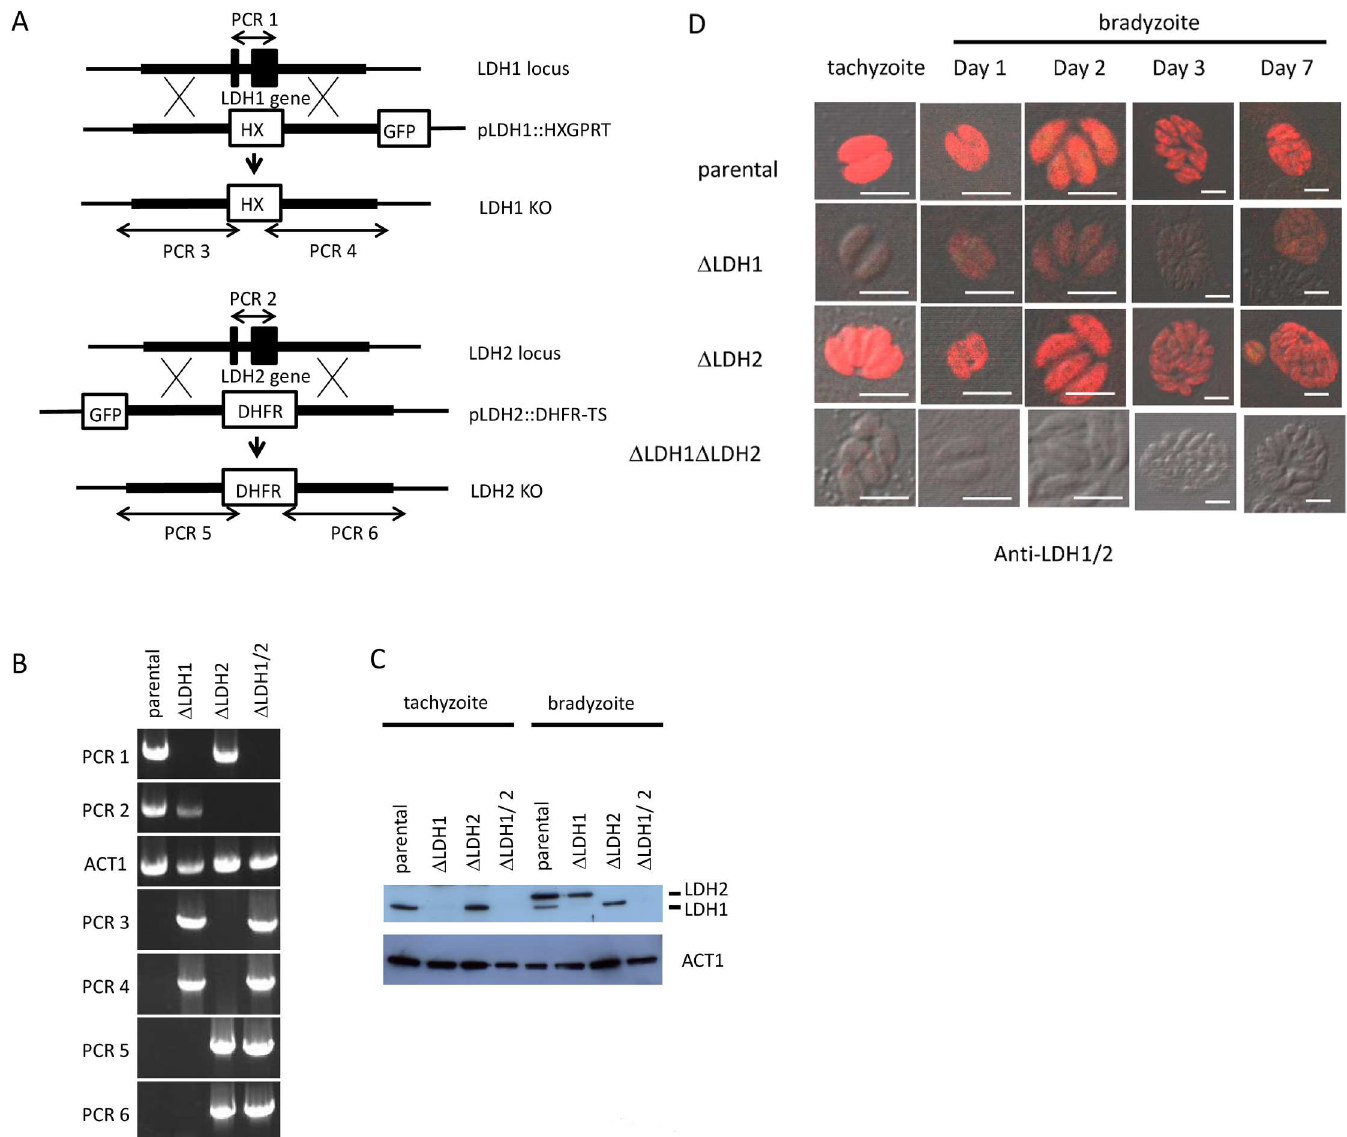
Fig 1. Construction of knockout strains. (A) Schematic diagramof LDH gene disruptionstrategy by doublecrossover homologous recombination in type II Pru Δ ku80 Δ hxgprt using a plasmid, p Δ LDHcontainingthe 5’ and 3’ flankingregion. HXGPRT and DHFR-TS selectablemarkers were used for selection. (B) PCR analysisfor validationof gene knockouts. Signalof coding regionof LDH1 (PCR1) is absent in Δ ldh1 and Δ ldh1 Δ ldh2 strains. Signalof coding regionof LDH2(PCR2) is absent in Δ ldh2 and Δ ldh1 Δ ldh2 strains. The actin coding region(ACT1) was used as a PCR control. Successful homologous recombination is indicatedby the presence of signal of either LDH1 (PCR3 and 4) in Δ ldh1 and Δ ldh1/2 or LDH2 (PCR5 and 6) in Δ ldh2 and Δ ldh1/2 strains. (C) Western blot analysisof parentaland knockout parasitelysates of tachyzoiteand bradyzoitestage. Anti-LDH1/2antibody which recognizes both LDH1 and 2 proteins was used. LDH1signal is absent in Δ ldh1 and Δ ldh1/2 strains and LDH2 signal is absent in Δ ldh2 and Δ ldh1/2 strains. Although the predicted molecularweight of LDH1 and 2 is nearly identical(35.5 and 35.3 kDa, respectively), western blot antibody reactive bands of LDH2migrated at an apparent highermolecularweight than LDH1. (D) Immunofluorescence stainingof parentaland knockout parasitelysates of tachyzoite and bradyzoitestage. Anti- LDH1/2antibody which recognize both LDH1and 2 proteins are used. In the LDH1 disruption, weak signal graduallyappearedafter bradyzoiteinduction. No signalwas detected in the candidate LDH1/LDH2 doubleknockout parasites. White bar in photos indicates10 μ m.